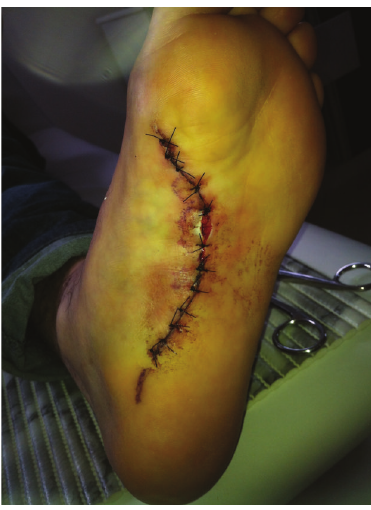
Figure 10: Good healing at 3-week follow-up, with only mild epidermolysis in the center of the wound.